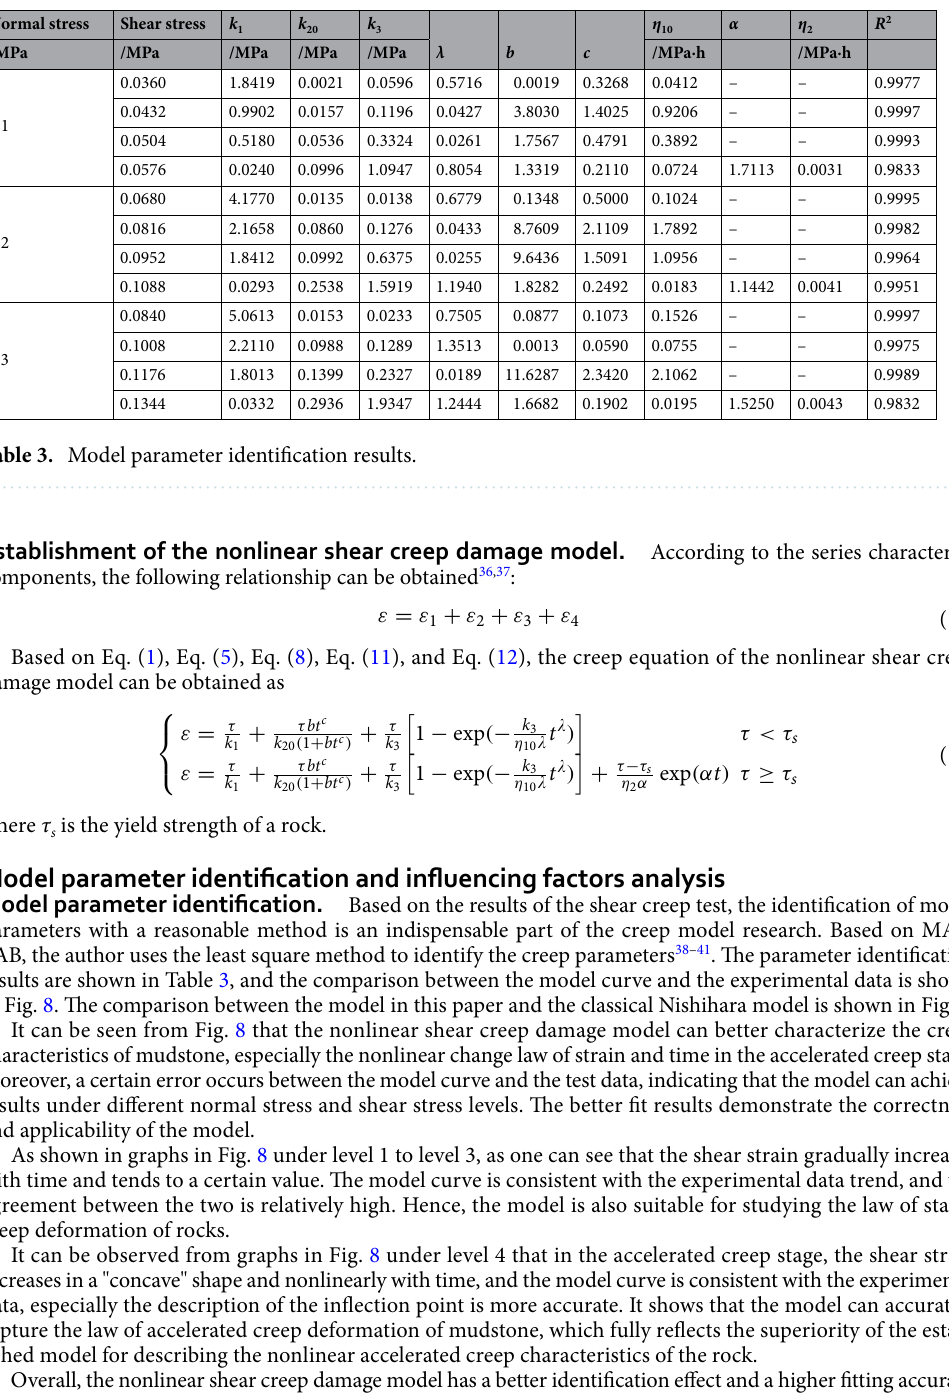
Fig. 10a,b shows the influence of different values of parameters b and c on the creep curve of nonlinear elastomer,